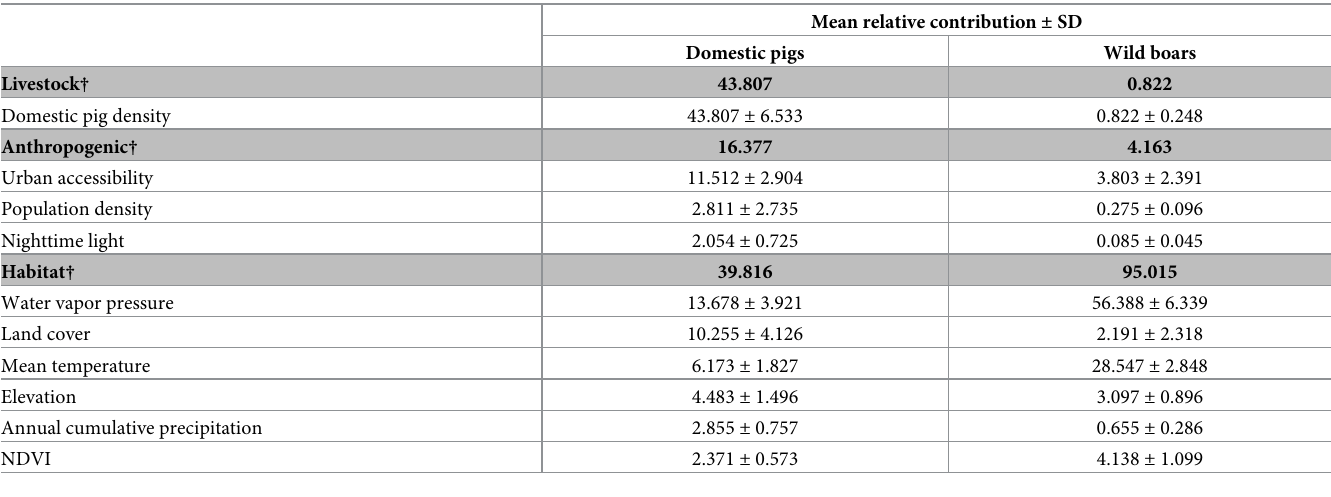
Table 1. Relative contribution of livestock, anthropogenic and habitat covariates derived from the ensemble BRT models.